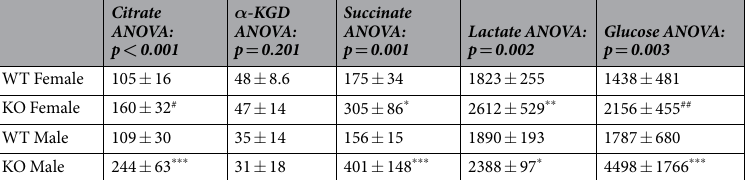
Citrate ANOVA: p < 0.001